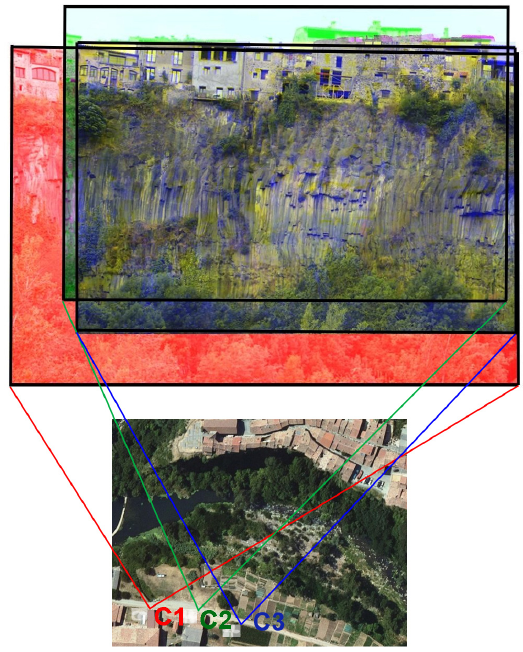
Figure 2. Ortophotography with the cameras’ positions and the wall area covered by each one. In red, green and blue: the areas covered by cameras C1, C2 and C3, respectively.